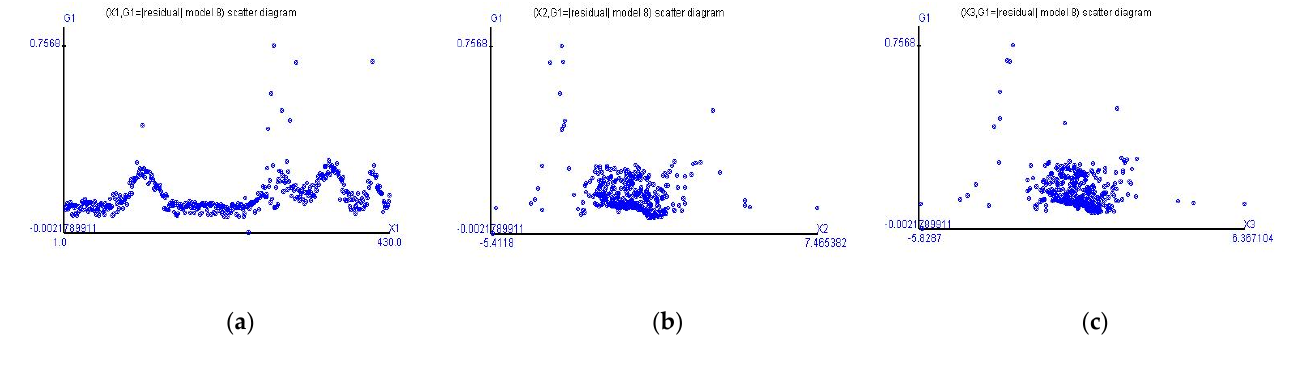
Table A1. List of 37 functions for the explanatory variable in nonlinear